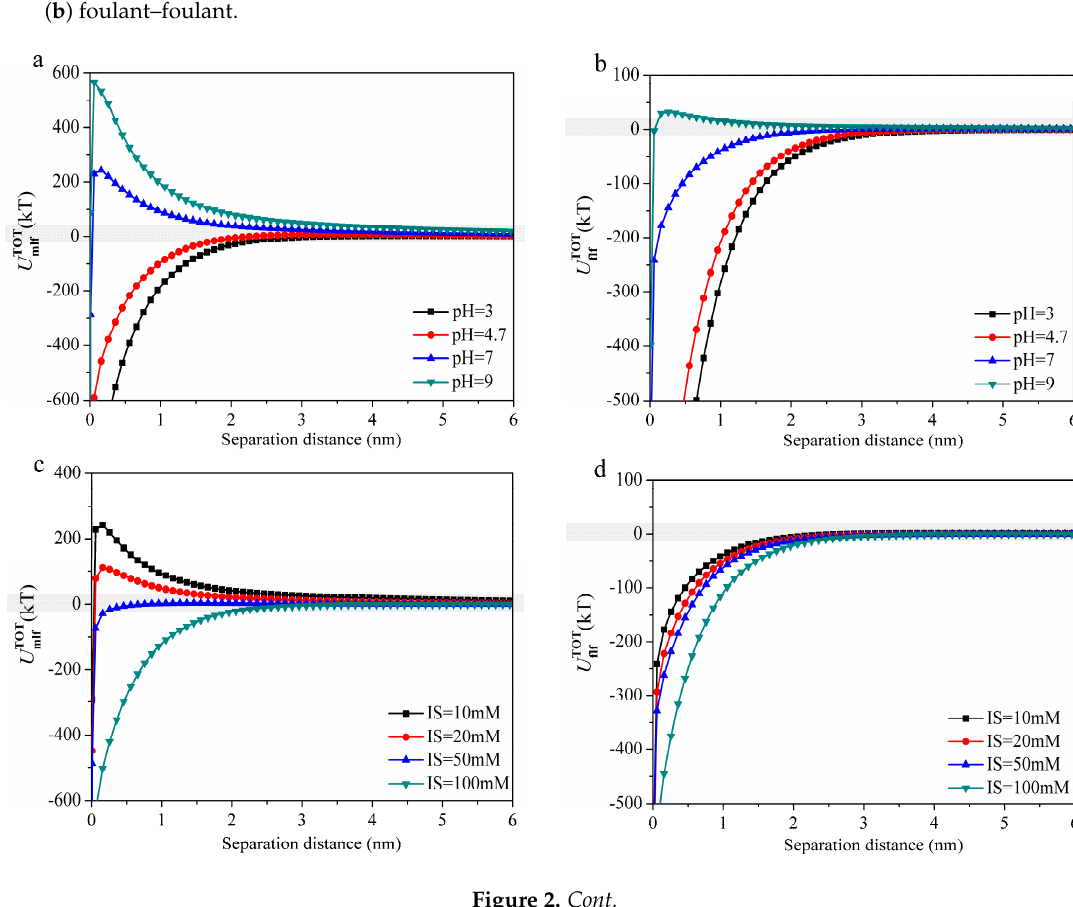
Figure 2. Variations in interaction energies of membrane–foulant and foulant–foulant with separation distance at different solution conditions: ( a , b ) pH; ( c , d ) IS; ( e , f ) Ca 2+ concentration. According to the above trends of total interaction energies with solution conditions, some qualitative predictions about MF membrane fouling caused by HA–BSA mixtures can be yielded. The membrane fouling potential of HA–BSA mixtures would follow the order of pH = 3.0 > pH = 4.7 > pH = 7.0 > pH = 9.0; IS = 100 mM > IS = 50 mM > IS = 20 mM > IS = 10 mM; and c(Ca 2+ ) = 1.0 mM > c(Ca 2+ ) = 0.5 mM > c(Ca 2+ ) = 0.2 mM > c(Ca 2+ ) = 0 mM. 3.4. Experimental Verification In order to verify the above theoretical predictions, the normalized flux reduction curves of the HA–BSA mixtures at different solution conditions are depicted in Figure 3. It can be observed that great flux decline was found at the beginning of filtration, and then, the speed of flux decline gradually decreased. This observation is consistent with previous reports on the behavior of membrane fouling during different filtration periods [42,43]. It can be seen from Figure 3a that when filtrating the HA–BSA mixtures at different solution pH, fouling propensity was in the order of pH =